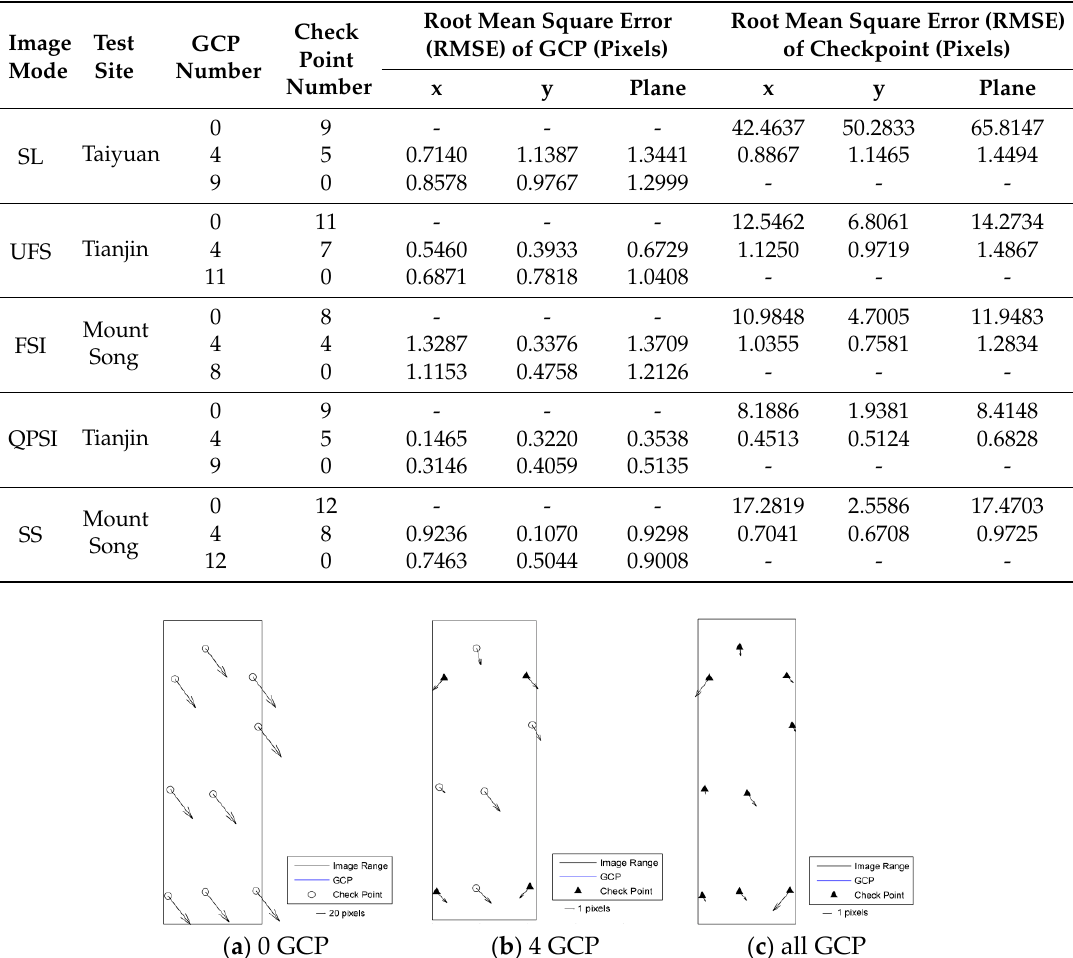
Figure 3. Residual distributions of check points of the SL mode orientation for Taiyuan. ( a ) 0 GCP; ( b ) 4 GCP; ( c ) all